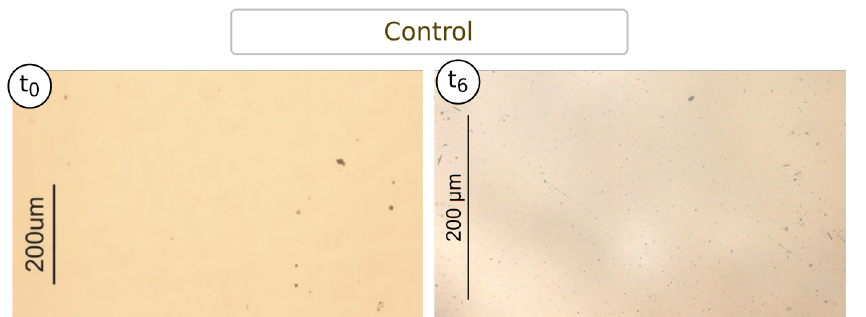
Figure A1. Optical microscopy results form the control samples.